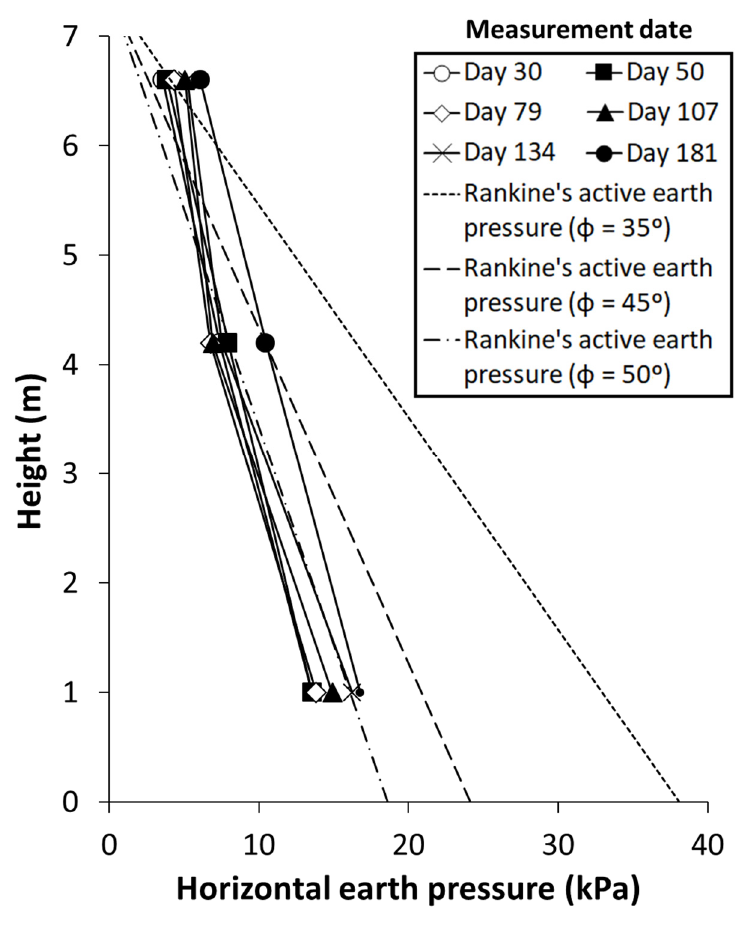
Figure 10. Variation in horizontal earth pressure over